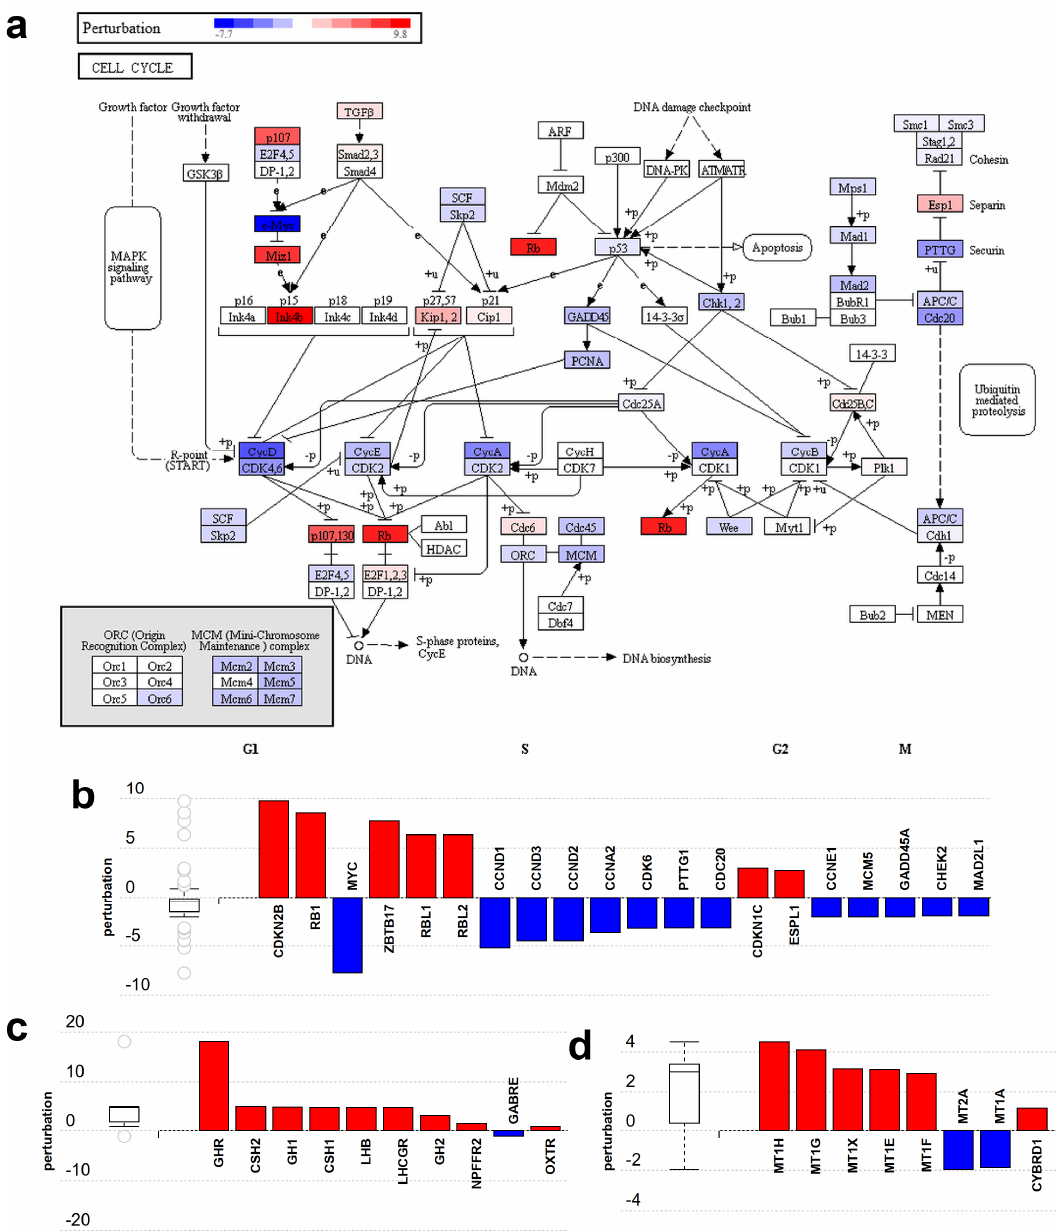
Figure 5. Gene perturbation analysis by iPathwayGuide: Perturbation of non-placental-module genes in the cell cycle pathway (KEGG:04110). ( a ) The pathway diagram is overlaid with the computed perturbation of each gene. The perturbation accounts both for the gene’s measured fold change and for the accumulated perturbation from any upstream genes. The highest negative perturbation ( − 7.7) is shown in dark blue, while dark red represents the highest positive perturbation (9.8). Note: For legibility, one gene may be represented in multiple places in the diagram and one box may represent multiple genes in the same gene family. For each gene family, the color corresponding to the gene with the highest absolute perturbation is displayed. ( b ) Gene perturbation bar plot. All the genes in the cell cycle pathway are ranked based on their absolute perturbation values. For each gene, the signed perturbation is represented with negative values in blue and positive values in red. The box and whisker plot on the left summarizes the distribution of all gene perturbations in this pathway. ( c , d ) show placental-module genes perturbed in the neuroactive ligand-receptor interaction pathway (KEGG:04080) and the mineral absorption pathway (KEGG:04978), respectively. Figures were generated by iPathwayGuide.